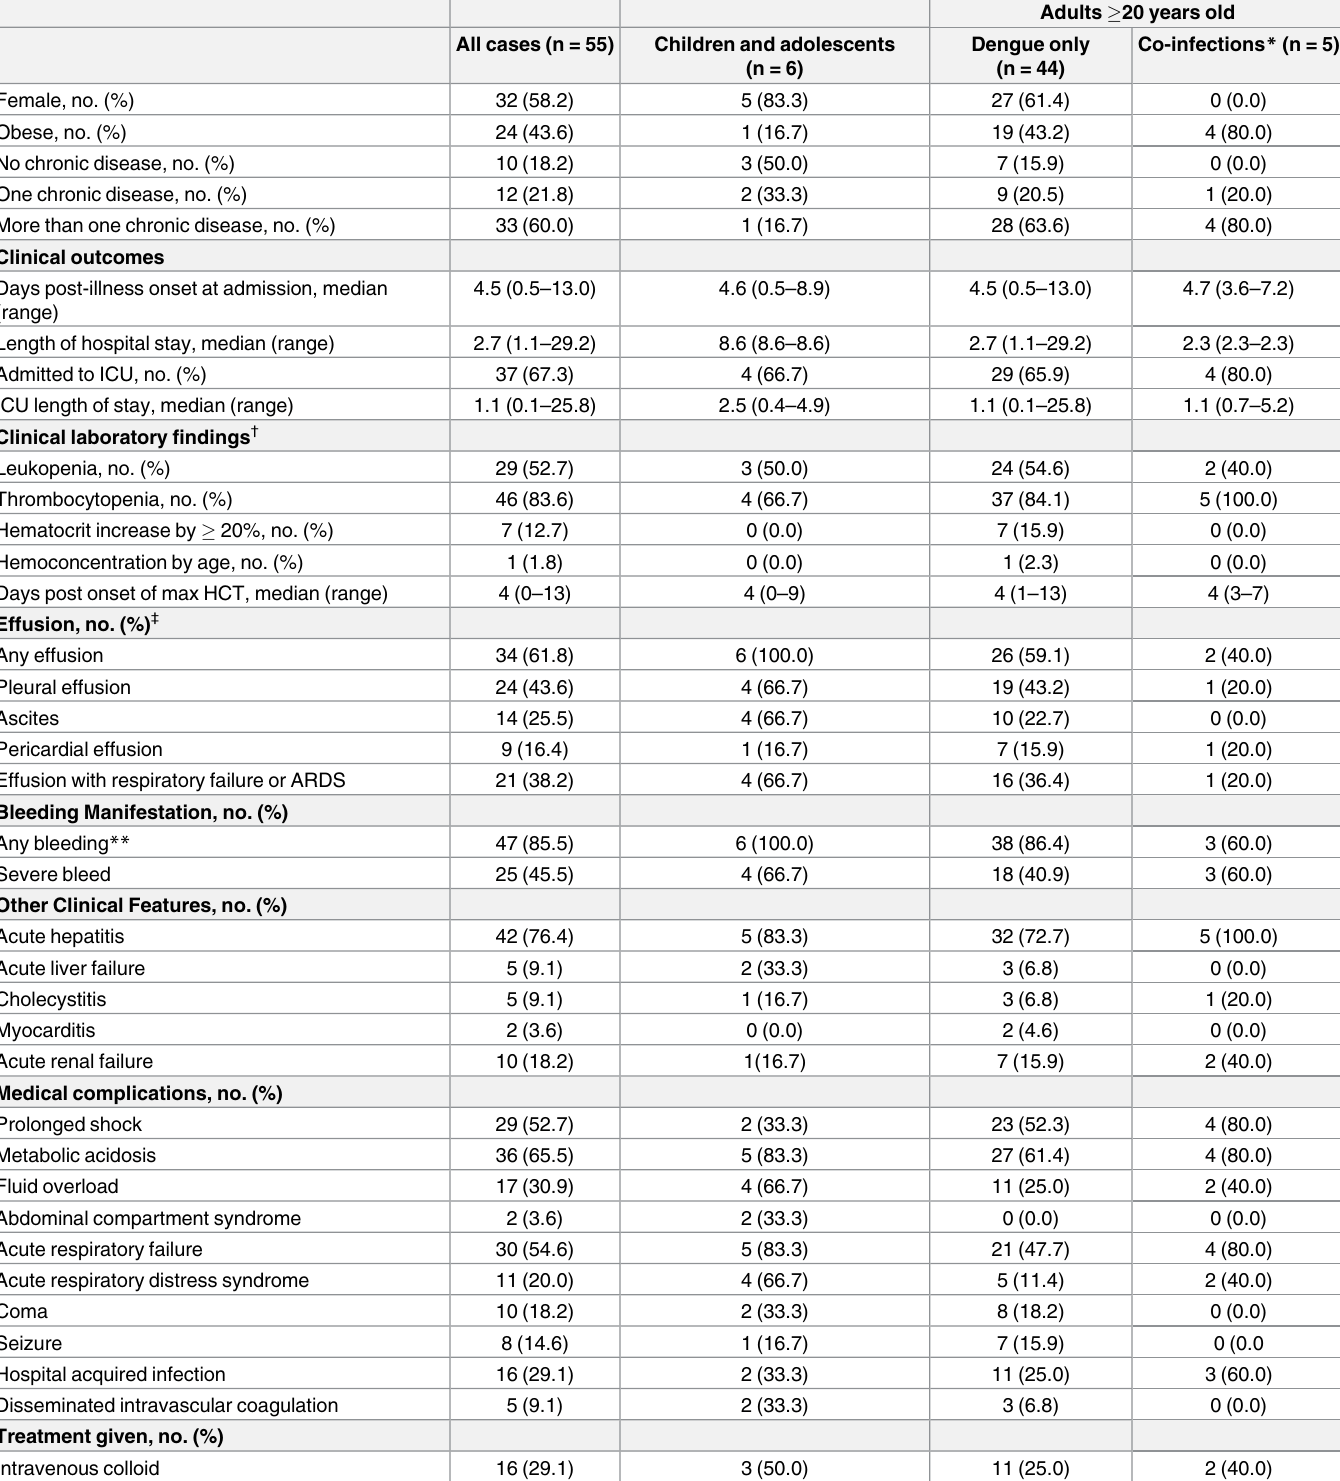
Table 5. Demographic characteristics, medical history and clinical outcomes for fatal laboratory-positive dengue case-patients detected by the Enhanced Fatal AFI Surveillance System who died in a hospital, Puerto Rico,